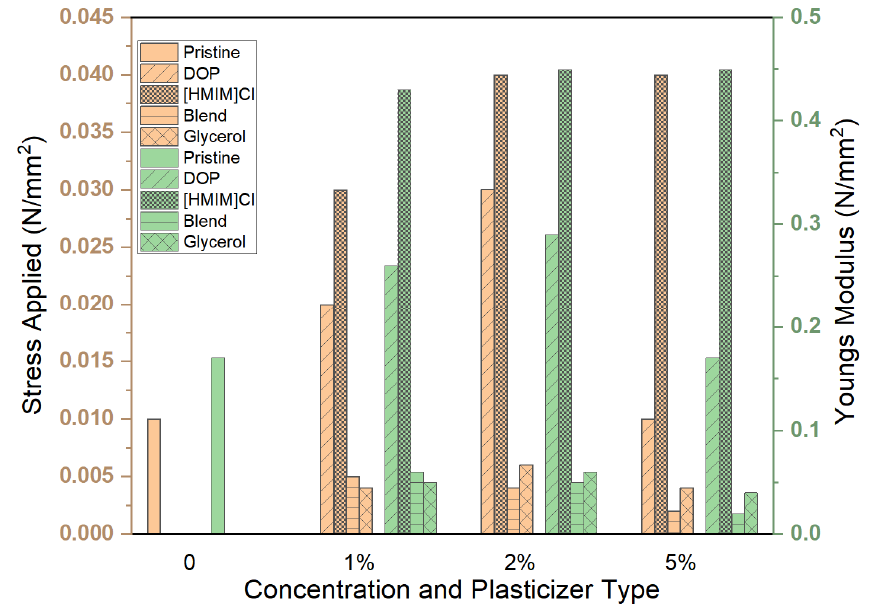
Figure 7. Effect of plasticizer type and concentration 1, 2 and 5% on the endured stresses and strains as a ramp displacement-type stress test was conducted. The resultant Young’s modulus has been calculated. For all samples, the strain endured was 0.1.